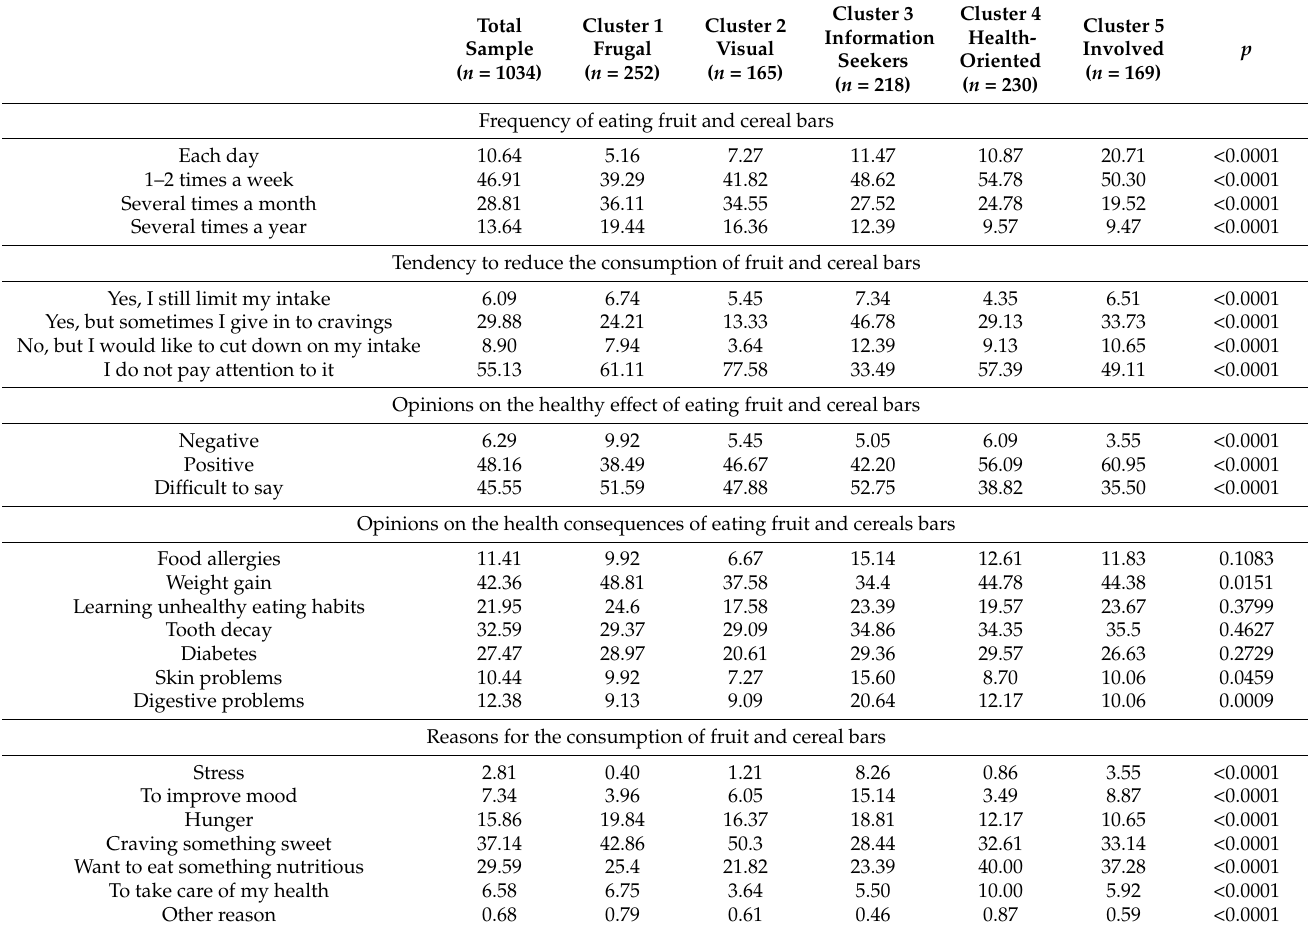
Table 5. Frequency of consumption and opinions on the health effects of fruit and cereal bar con- sumption according to the clusters’ adherence (%, n = 1034,